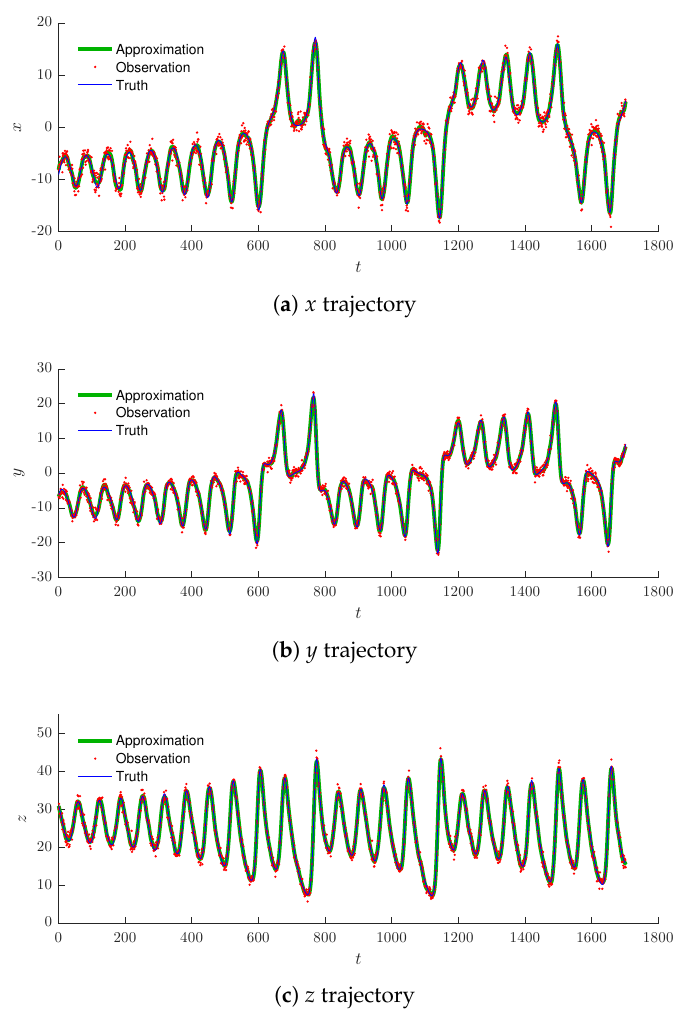
Figure 10. Projections onto each direction for the chaotic Lorenz